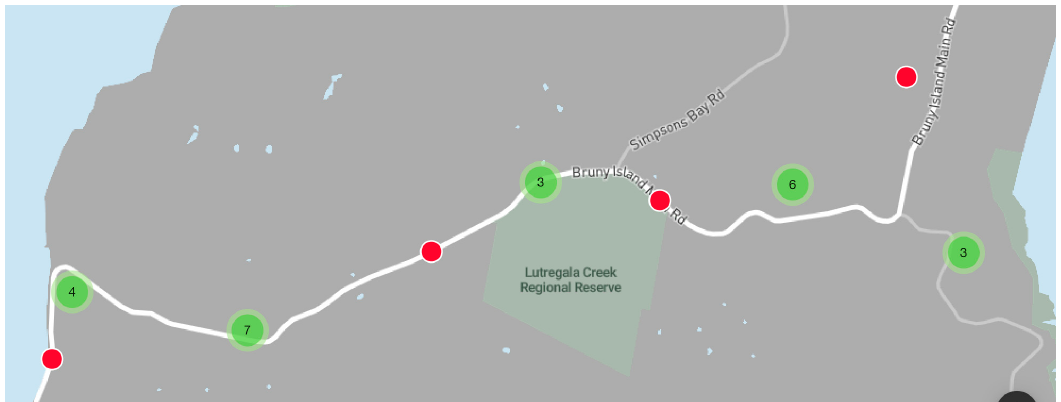
Figure 4. Roadkill hotspot on 6 km of highway between Alona on the west side and Adventure Bay on the east side of Bruny Island Tasmania.